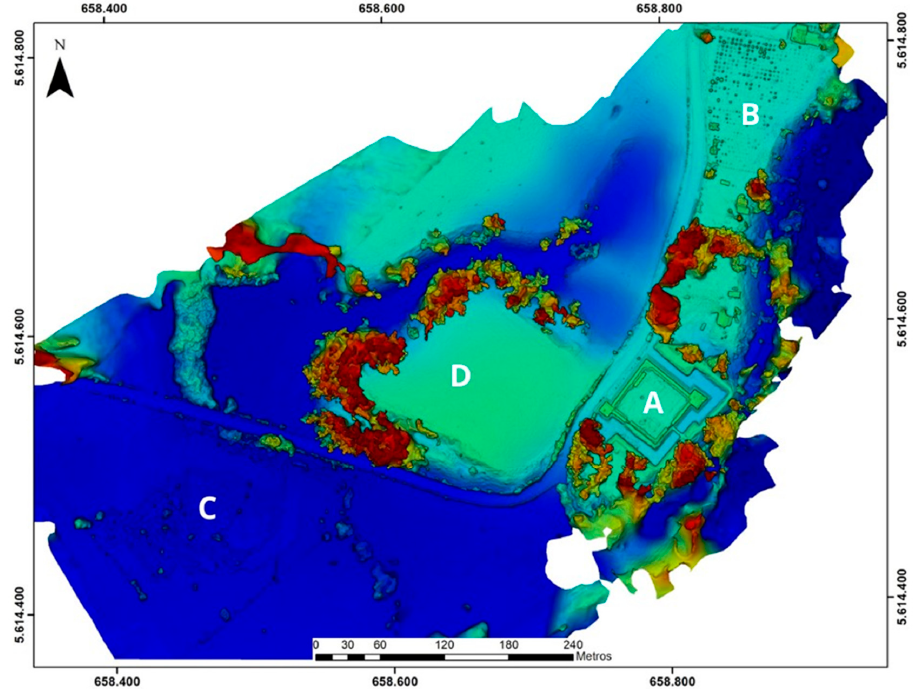
Figure 5. Possible remains of Cruces Village and the San Luis del Alba Fort, September and October 2021. ( A ) San Luis del Alba Fort. ( B ) Possible remains of Cruces Village to the north of the fort. ( C ) Possible remains of Cruces Village to the south of the fort. ( D ) Mound or hill.